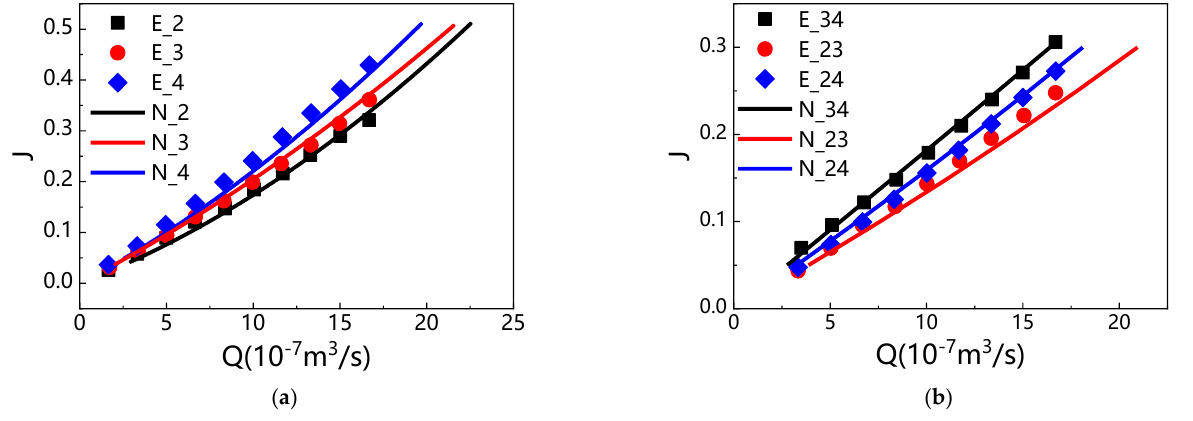
Figure 11. Comparison of the experimental results with the numerical code results of Model 1: ( a ) one inlet and one outlet; ( b ) one inlet and two outlets.